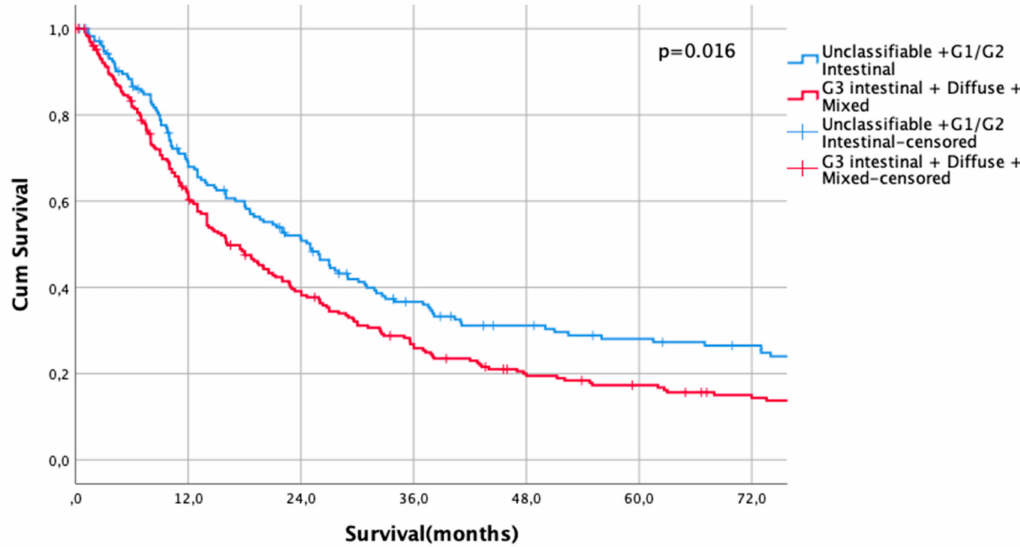
Figure 5. Survival curves for differentiated/undifferentiated subtypes after PSM in UICC III stage. Survival UICC III ( n = 407) for a differentiated type (unclassifiable Lauren type, Lauren intestinal type G1 and G2) vs. undifferentiated type (Lauren intestinal type, diffuse type, and mixed type). HR 1.32, CI95% 1.05–1.64, p =